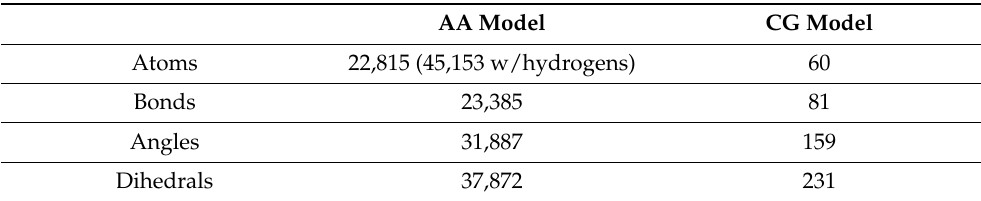
Figure 1. Structural visualization for AA vs. CG model. Red, blue, and green denote 3 chains. Table 1. Statistics for AA vs. CG model. Table 1. Statistics for AA vs. CG